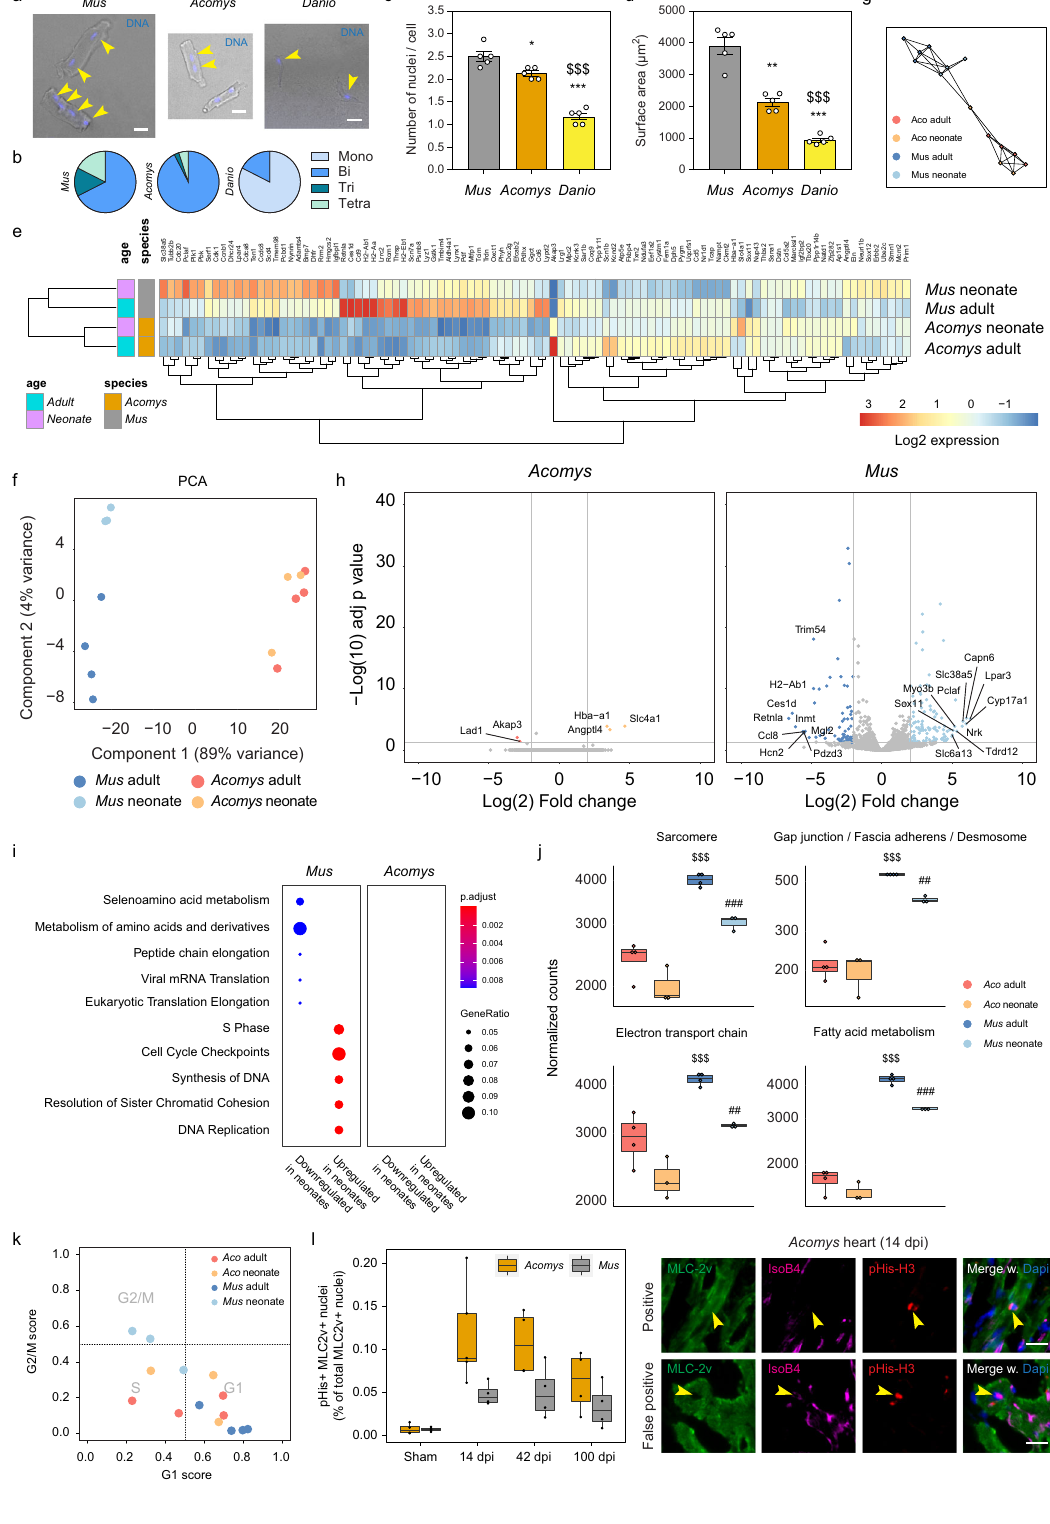
(Fig. 5d and Supplementary Fig. 7a). More speci fi cally, IGFBP-2 and Platelet factor 4 were uniquely expressed in injured Ac hearts, while B6 hearts were associated with increased expression of Osteopontin and Serpin E1 (Fig. 5d). We next investigated the epicardium, a mesothelium covering the surface of the heart.